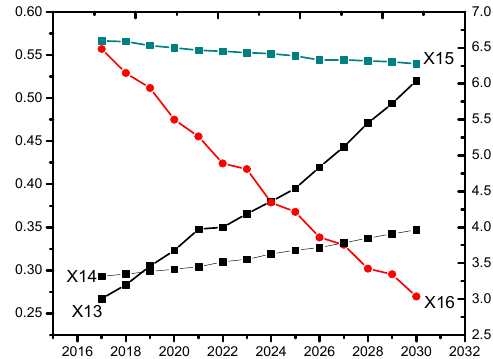
Figure 7. Predictions for the technical sustainability of ESSI.